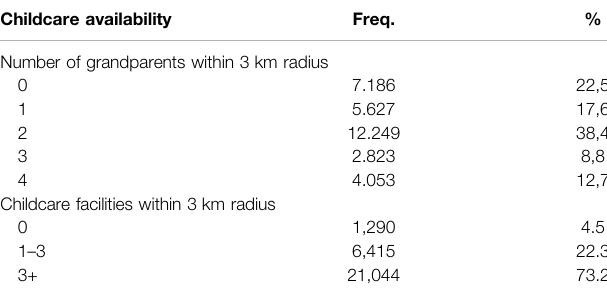
TABLE 4 | Summary statistics of childcare availability variables. Childcare